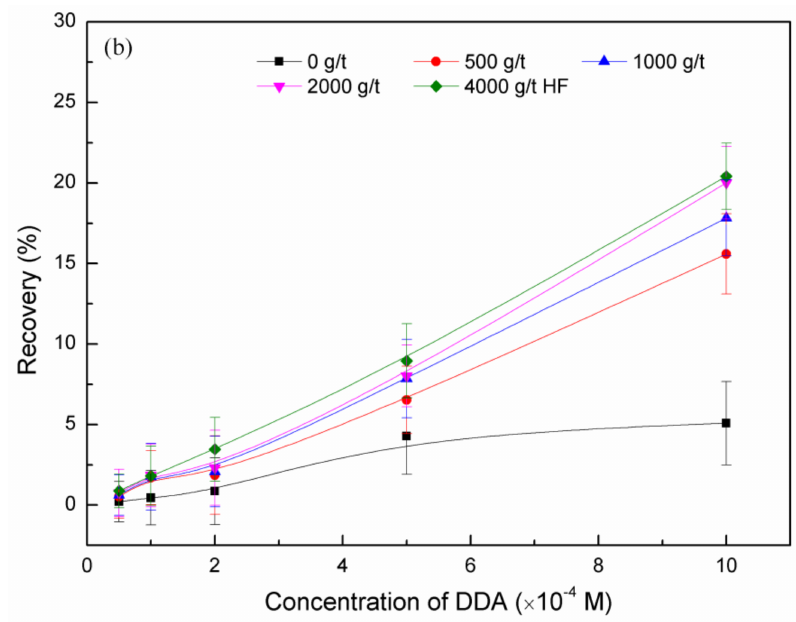
Figure 3. Flotation recovery of feldspar ( a ) and quartz ( b ) as a function of dodecylamine (DDA) and hydrofluoric acid (HF)